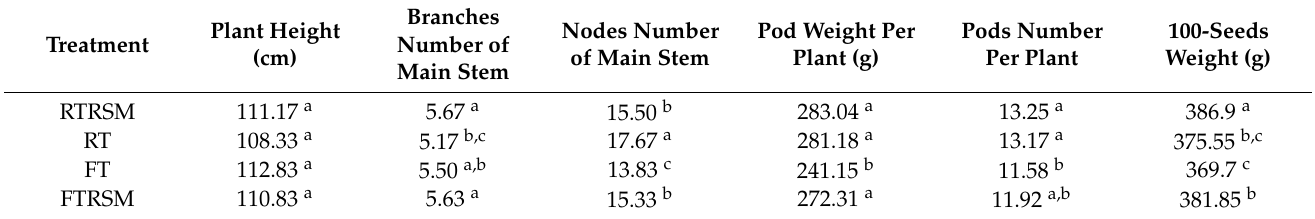
between treatments.